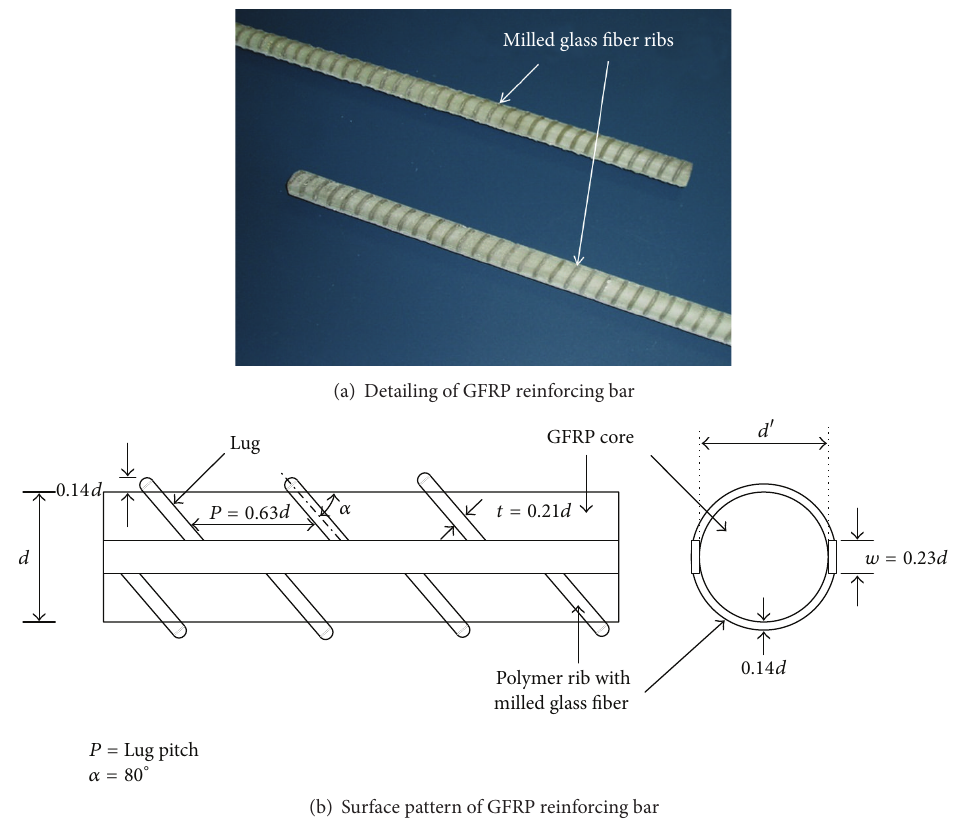
Figure 1: GFRP reinforcing bar used in this study